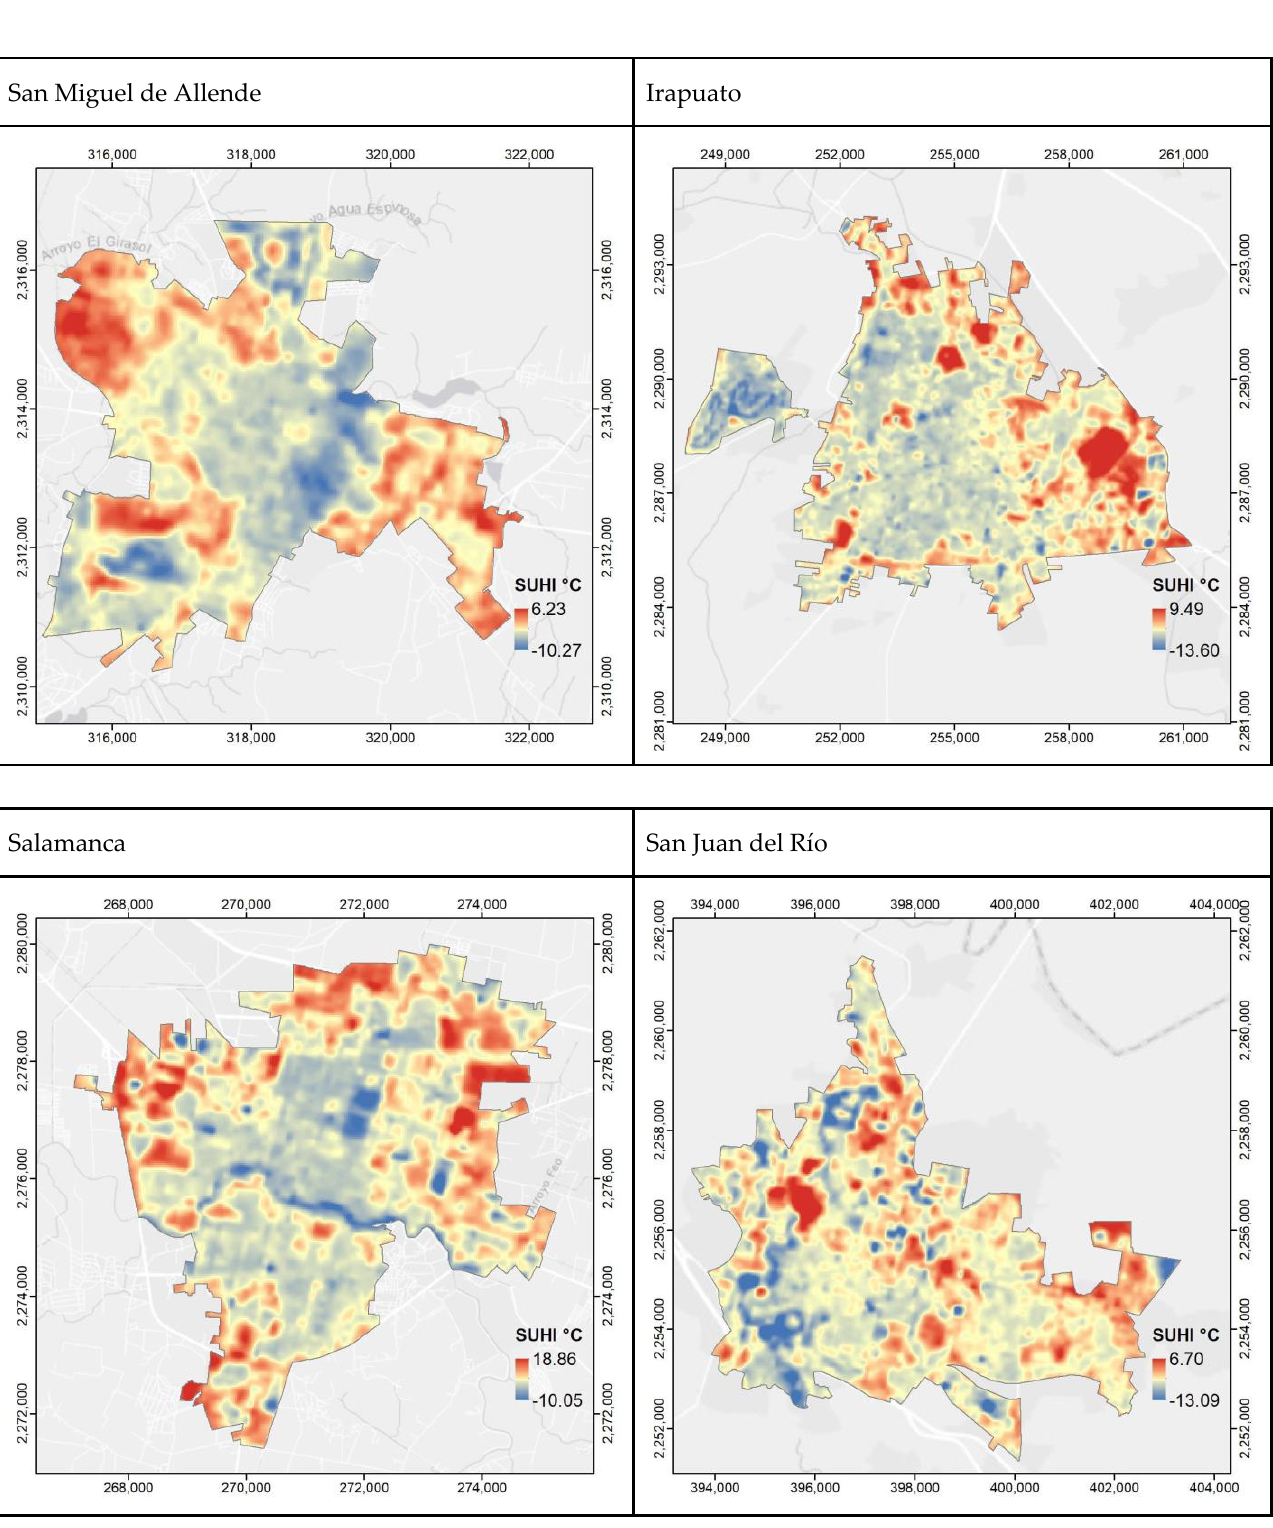
Figure A2. Landsat Daytime Surface Urban Heat Island of the Ten Metropolitan Cities and Four Conurbations in May 2020, with SUN key.